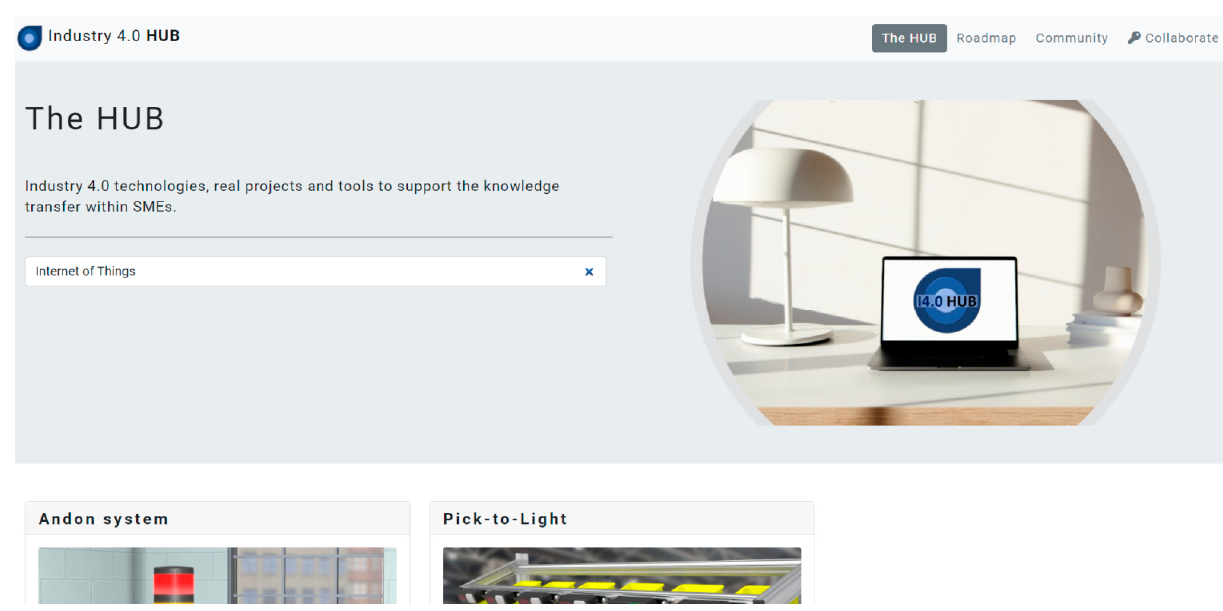
Figure 8. Industry 4.0 HUB desktop user interface.